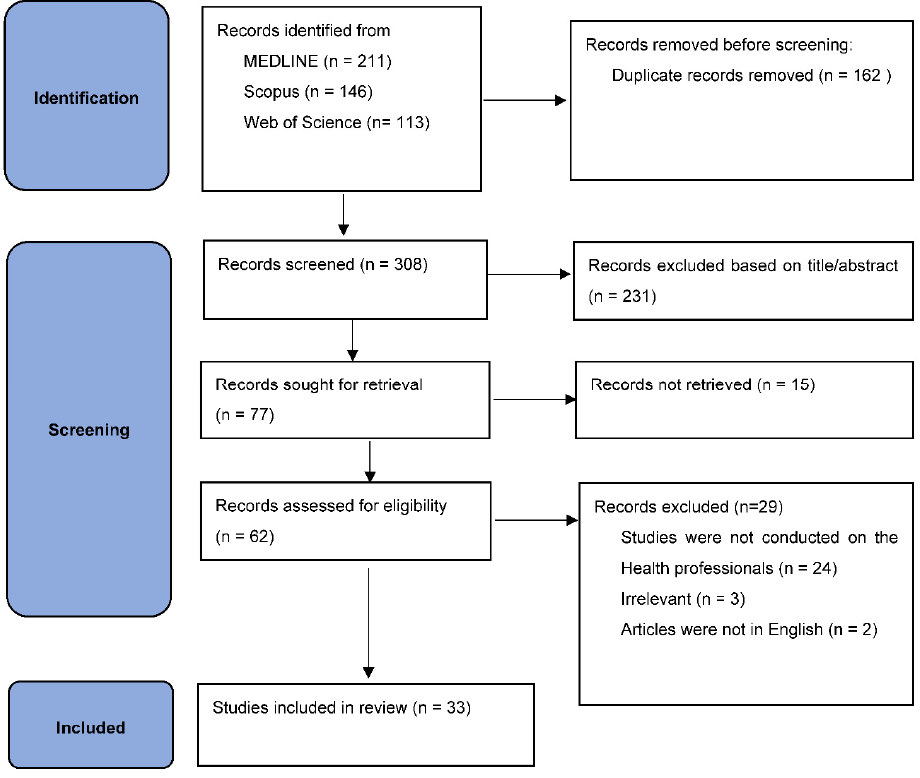
Figure 1. PRISMA flow diagram.